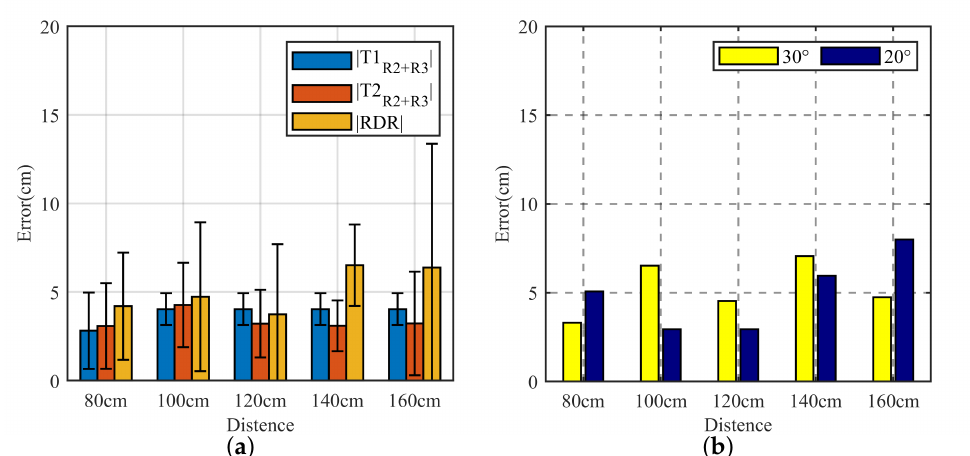
Figure 13. MAL positioning error. ( a ) Horizontal distance error. ( b ) Multi-target resolution